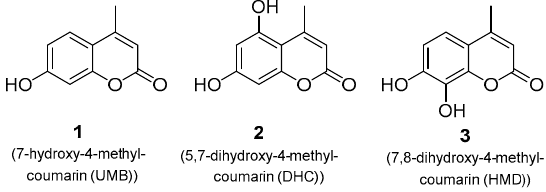
Figure 3. Coumarin structures reported by Couttolenc et al. [30].